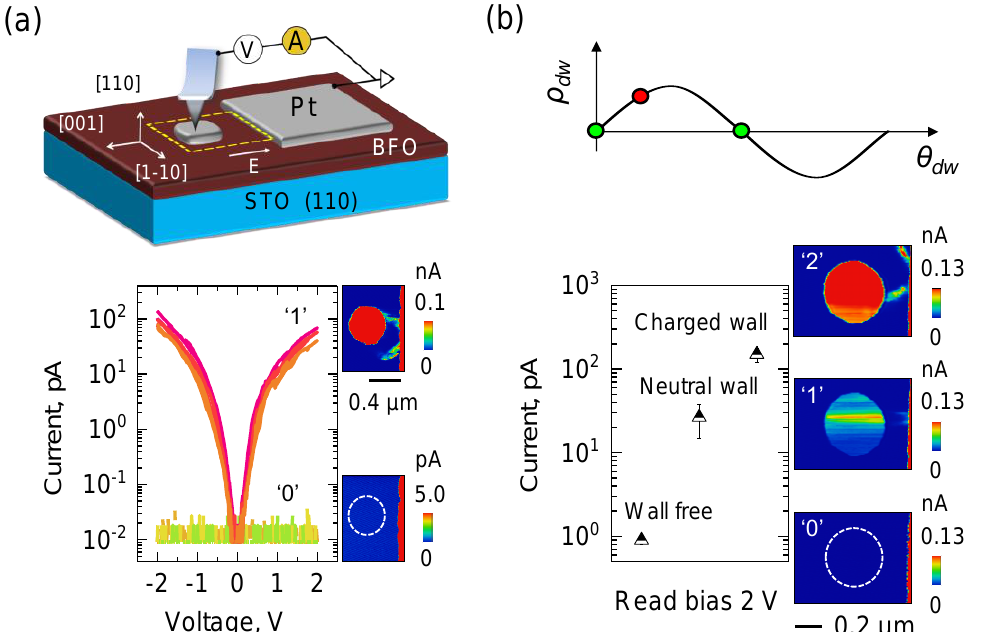
Figure 4. Domain wall memory and multilevel states: ( a ) Sketch of experimental geometry for a prototype domain wall memory device (top). I-V characteristics and current maps of the device in the presence (‘1′) and absence (‘0′) of domain walls (bottom). ( b ) Evolution of polarization charge, ρ dw , on domain wall plane versus wall angle, θ (top). Measured conduction levels and representative current maps of domain wall device for wall configurations of no wall, neutral, and charged walls (bottom) [3,170].